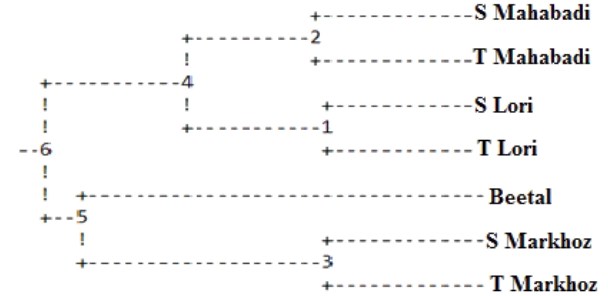
Figure 2. The phylogenetic dendrogram showing the genetic rela- tionships between the single (S) and twin-birth (T) subpopulations of the goat breeds studied using the Nei (1978) standard genetic distance obtained from five ISSR markers.